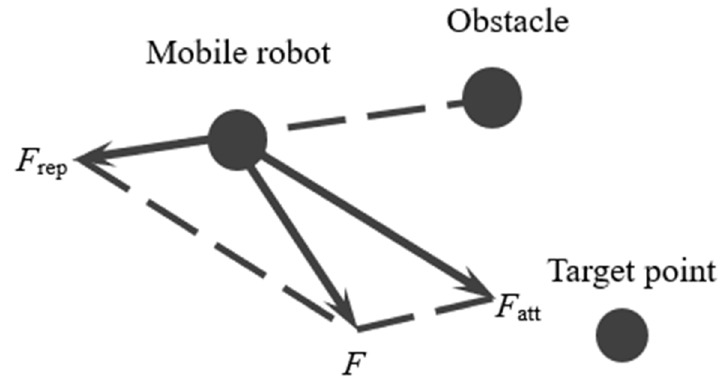
Figure 6. Stress diagram of artificial potential field method.